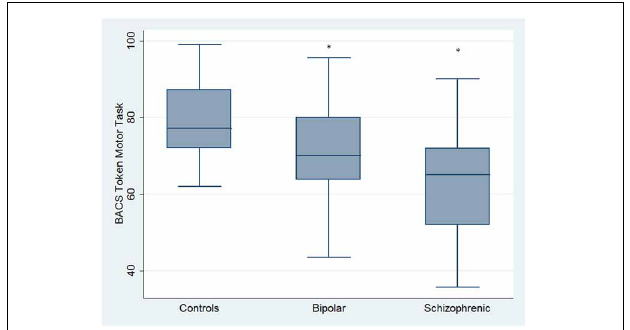
FIGURE 3 | Differences between groups in neuropsychological tasks: BACS motor speed. ∗ Significantly different from HC ( p < 0 . 05).